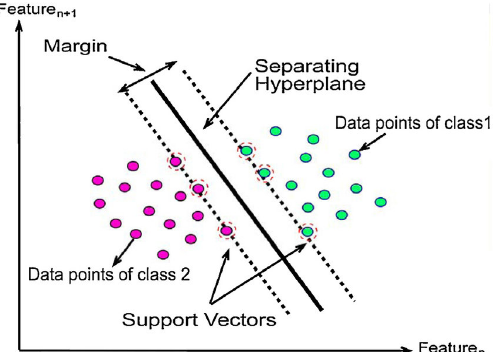
Figure 3. SVM hyperplane for linearly separable data points